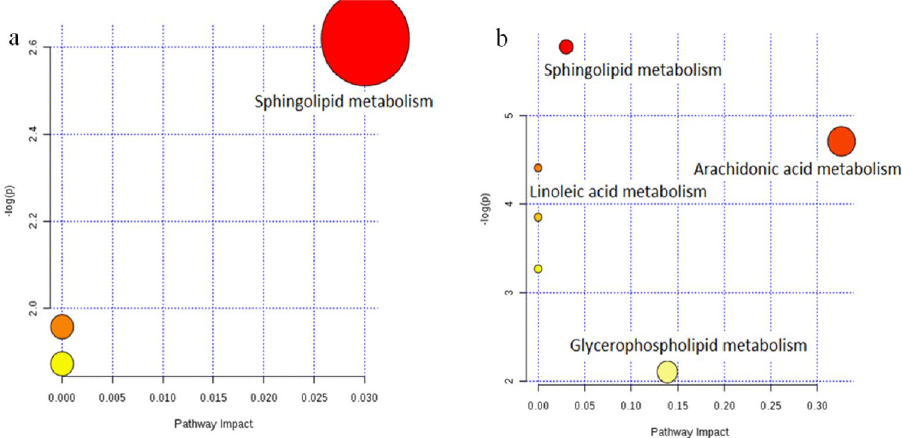
Figure 8. Pathway analysis on biomarkers of disease model ( a ) and DS model ( b ). All matched pathways according to p-values from pathway enrichment analysis and pathway impact values from pathway topology analysis, using pathway library of Rattus norvegicus (rat).